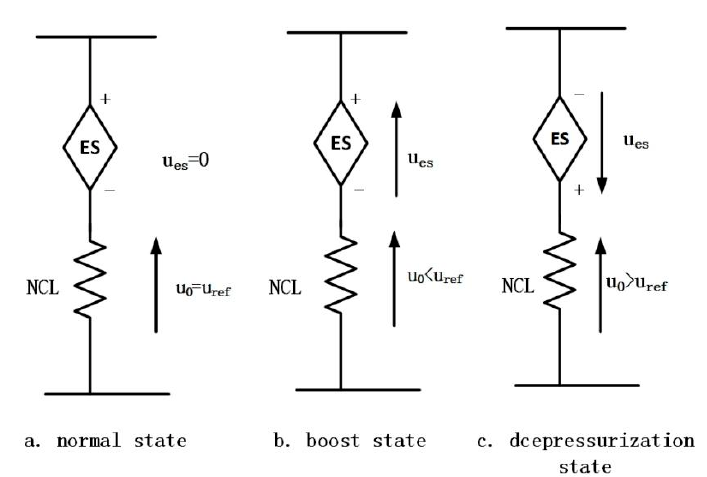
Figure 4. Working state of electric spring.